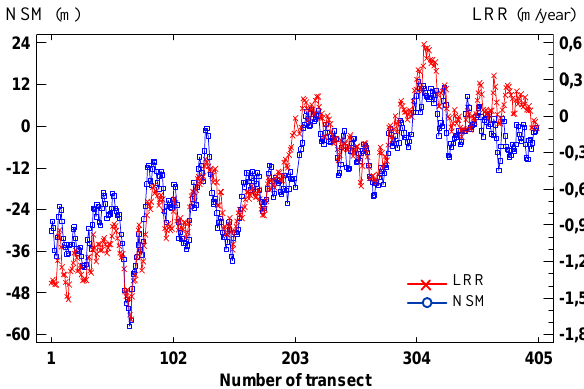
Figure 10. Net Shoreline Movement in m (NSM) and Linear Regression Rate in m/year (LRR). Results obtained with Landsat midlines (1984-2011) for each transect along the sector A.